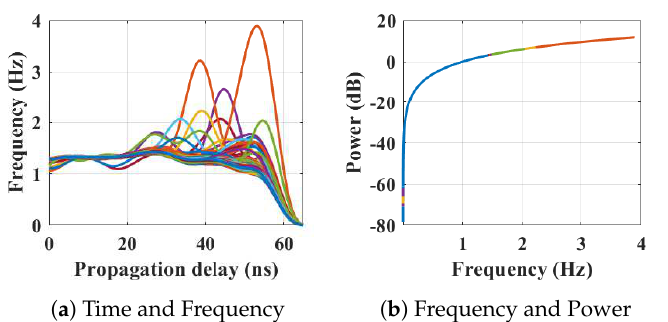
Figure 7. The relationship between propagation delay, activity frequency, and received power from the radar responses obtained while the person is eating in the dining room has been considered as C4 in classification phase.